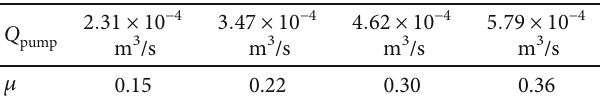
Table 3: The recovery ratio μ of contaminant for di ff erent pumping